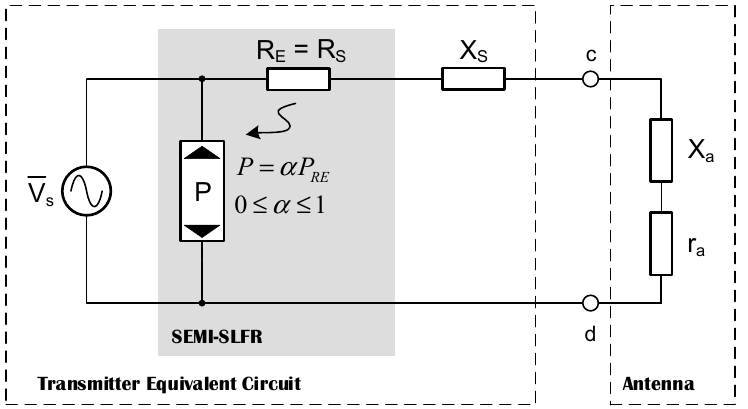
Figure 19. LFR and SLFR models. ( a ) LFR, ( b ) SLFR, ( c ) semi-SLFR and ( d ) power source characteristic.